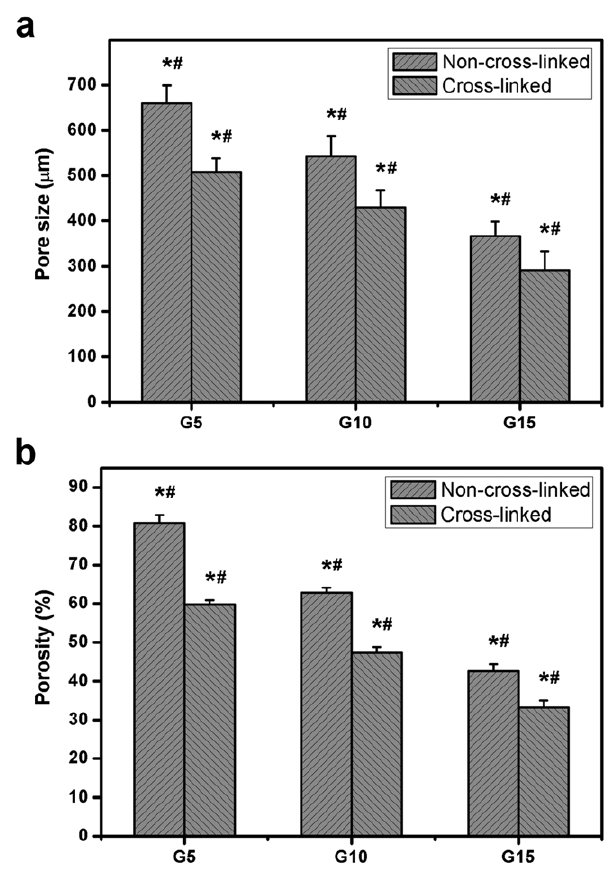
Figure 1. Characterization of porous structure. (a) Pore size and (b) porosity of various gelatin discs. An asterisk indicates statistically significant differences (* P , 0.05; n =4) between the non-cross-linked and cross-linked groups for each type of gelatin disc. # P , 0.05 versus all groups (compared only within non-cross-linked or cross-linked groups).